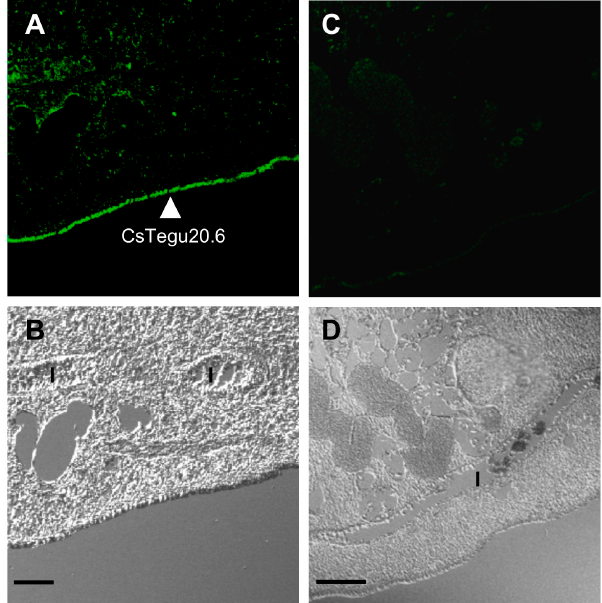
Figure 10. Immunohistochemical localization of CsTegu20.6 in C. sinensis adult worm. An adult fluke ( × 100) stained with 1:200 diluted FITC-conjugated anti-rat IgG antibody showed intense staining in the outer surface of the tegument (( A , B ), closed arrowhead); Non-immunized rat sera were used to make a negative control ( C , D ). The upper images showed the tegument and underlying tissues of adult worm under fluorescence microscope. The lower images showed the same part under optical microscope. Scale bars indicate 50 µ m. I, intestine.